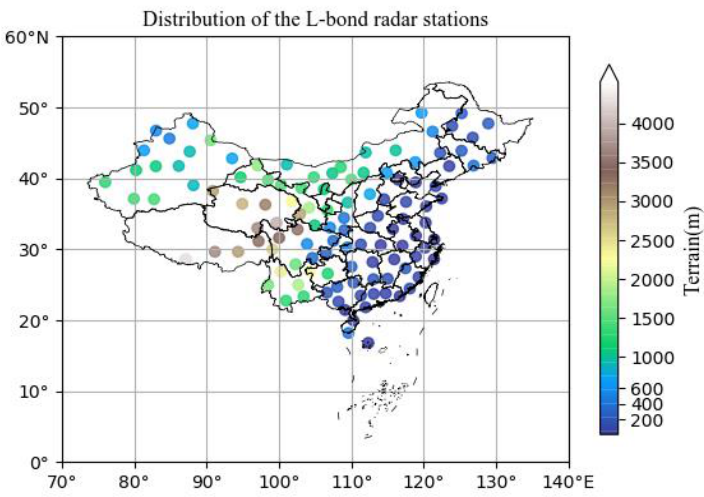
Figure 1. Location of the L-band radar stations in China.